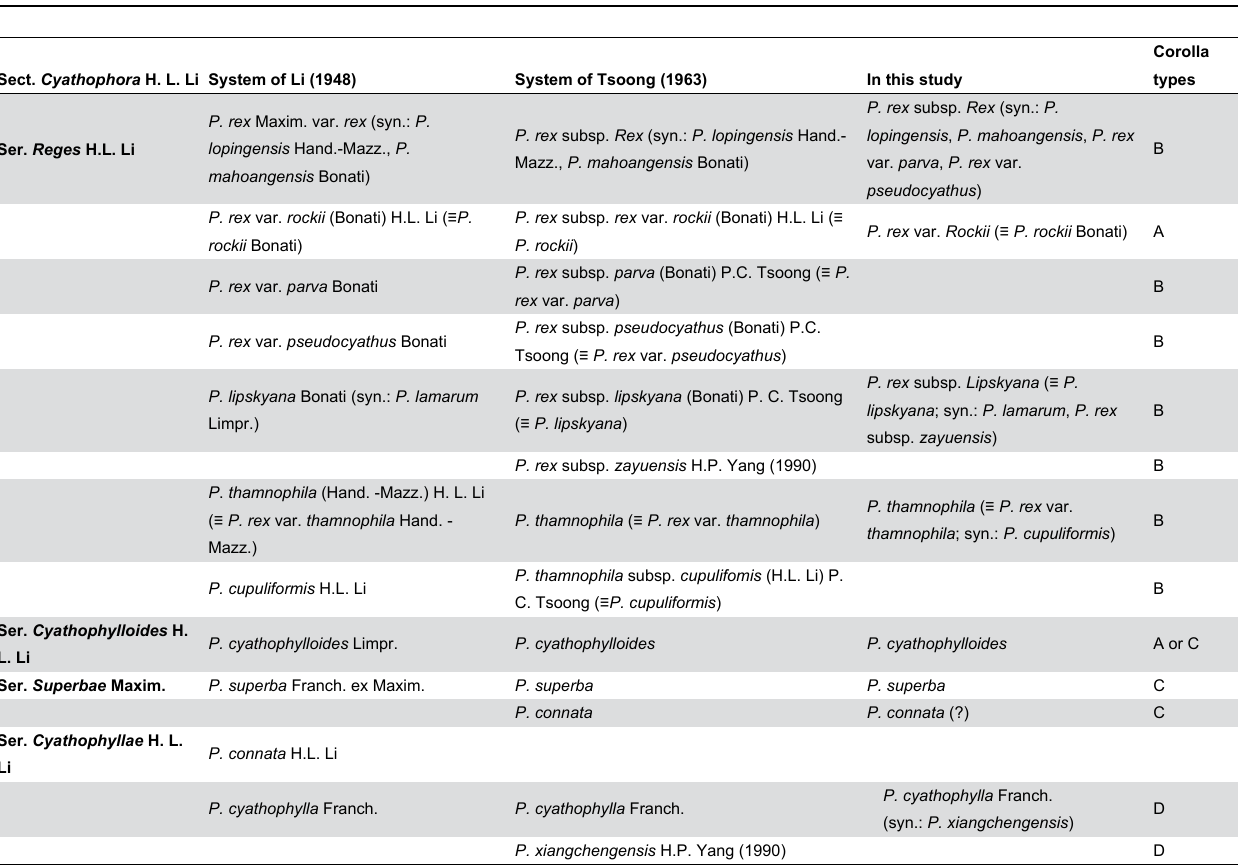
Table 1. Overview for the treatment of section Cyathophora in classification system of Li [6] and Tsoong [14], and in this